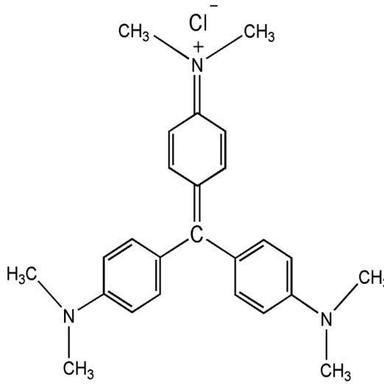
Chemical structural formula of CV dye.